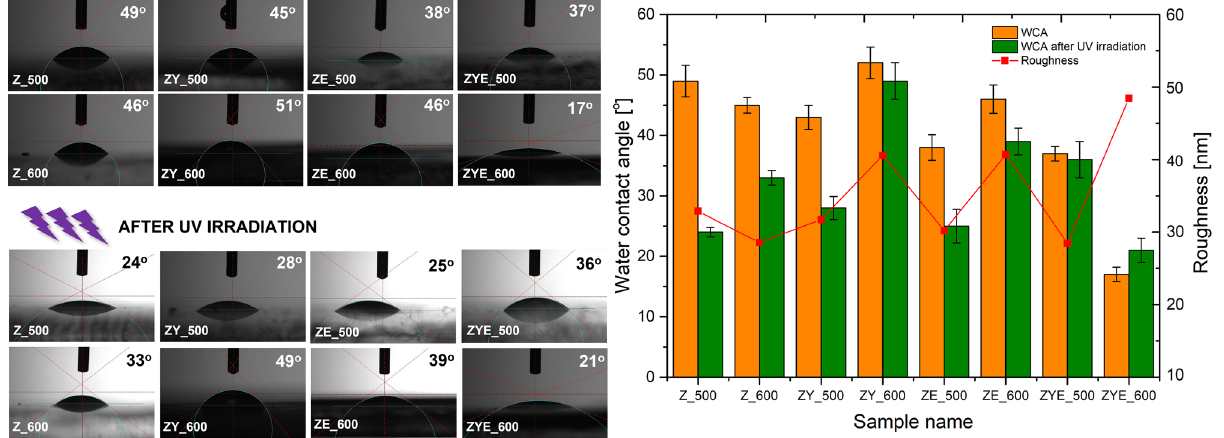
Figure 6. Water contact angle measurements of thin films: before and after UV light irradiation and scheme presenting the dependence of water contact angle values before and after UV irradiation on roughness of thin